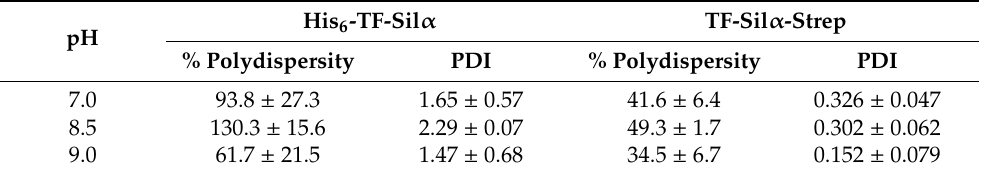
Table 5. Polydispersity and polydispersity index (PDI) of each protein, as predicted from the DLS data. Data shown are the average ± the standard deviation of two protein